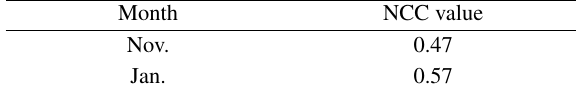
Table 11 NCC value between the Arabic tweets (classified as self) and count of actual hospital visits.